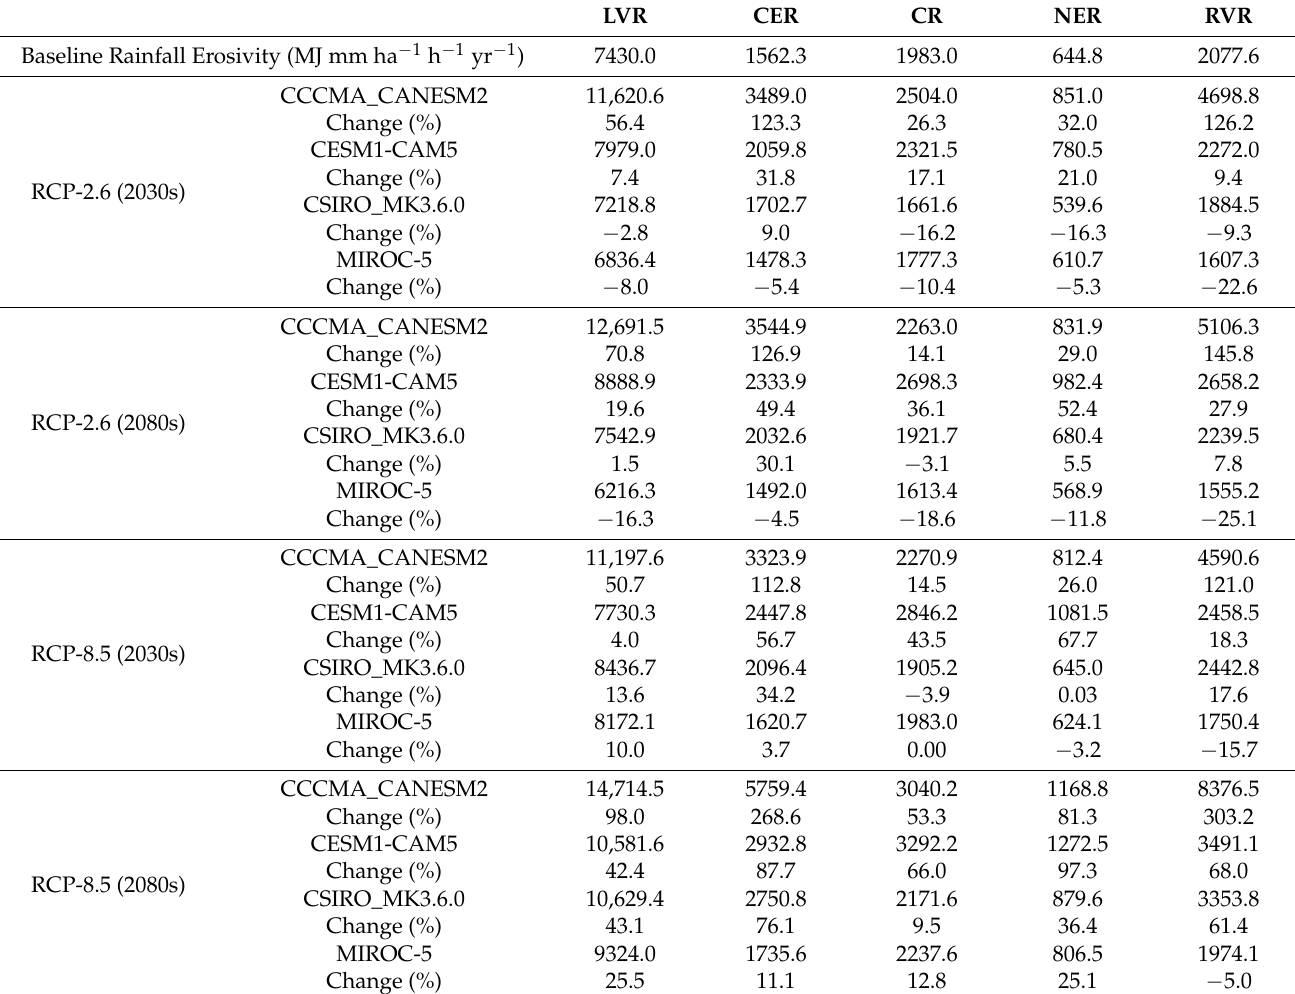
Table 15. Projected change to mean baseline rainfall erosivity (%) across the regions of